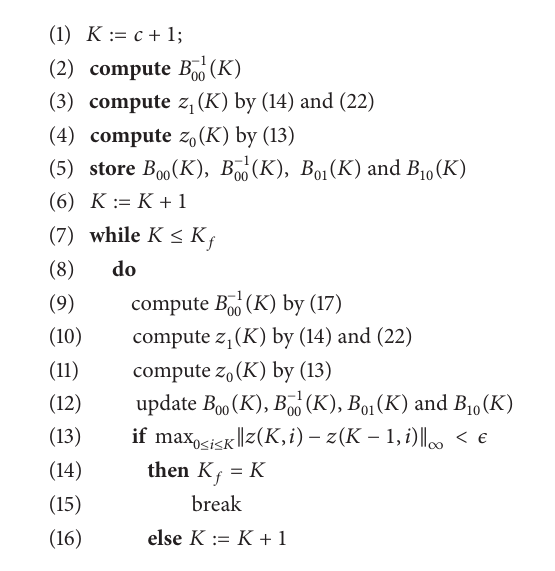
Algorithm 1: Finite truncation